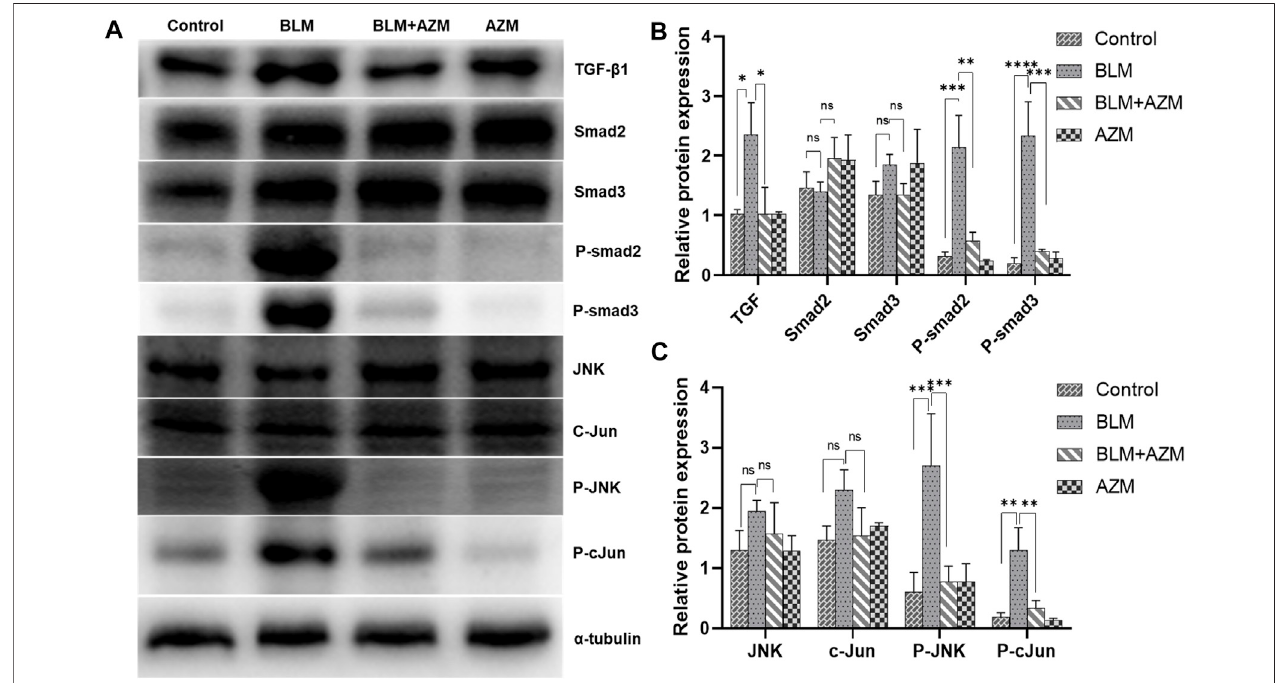
FIGURE 4 | AZM suppressed the TGF- β 1/Smad and JNK/c-Jun signaling pathway in BLM-induced mice. (A) Western blotting bands of TGF- β 1/Smad and JNK/ c-Junpathwayproteinsinlungtissueofmiceindifferentgroups. (B,C) TheproteinrelativeexpressionofTGF- β 1/SmadandJNK/c-Junpathwayproteinswasmeasured in each group by Western blot. Data were presented as the means ± SD ( n ≥ 3). ** p < 0.01, *** p < 0.001, **** p < 0.0001, ns, non-signi fi